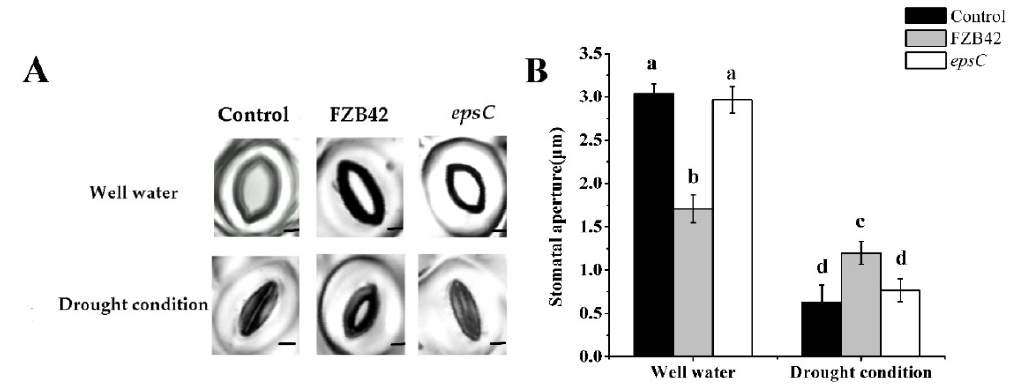
Figure 3. The physiological response of the A. thaliana leaf to drought stress. Appearance of stoma. Scale bar, 2.5 μm ( A ), and stomatal aperture in detached leaves of plants inoculated with either wild type FZB42 or the epsC mutant ( B ). Values are shown as means, with the whiskers representing the standard error (SE, n = 18). Different letters above each column indicate statistically significant ( p < 0.05) differences in mean performance.